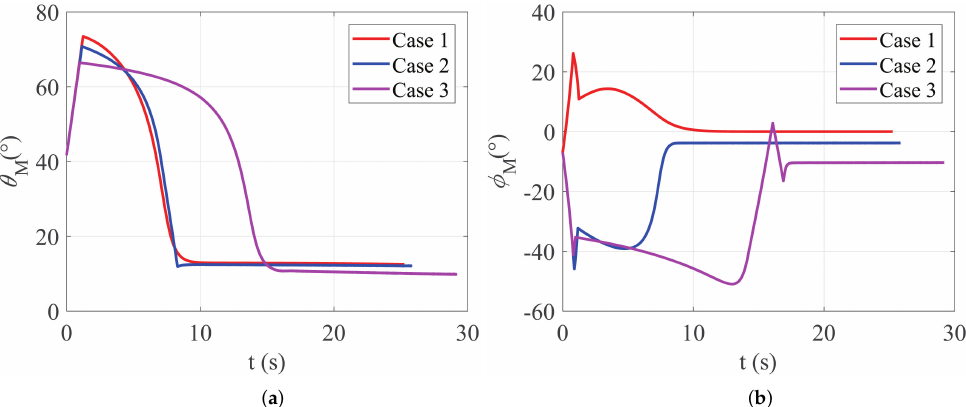
Figure 6. Variations of partial leading angles against constant maneuvering targets: ( a ) partial leading angles in pitch plane; ( b ) partial leading angles in yaw plane.